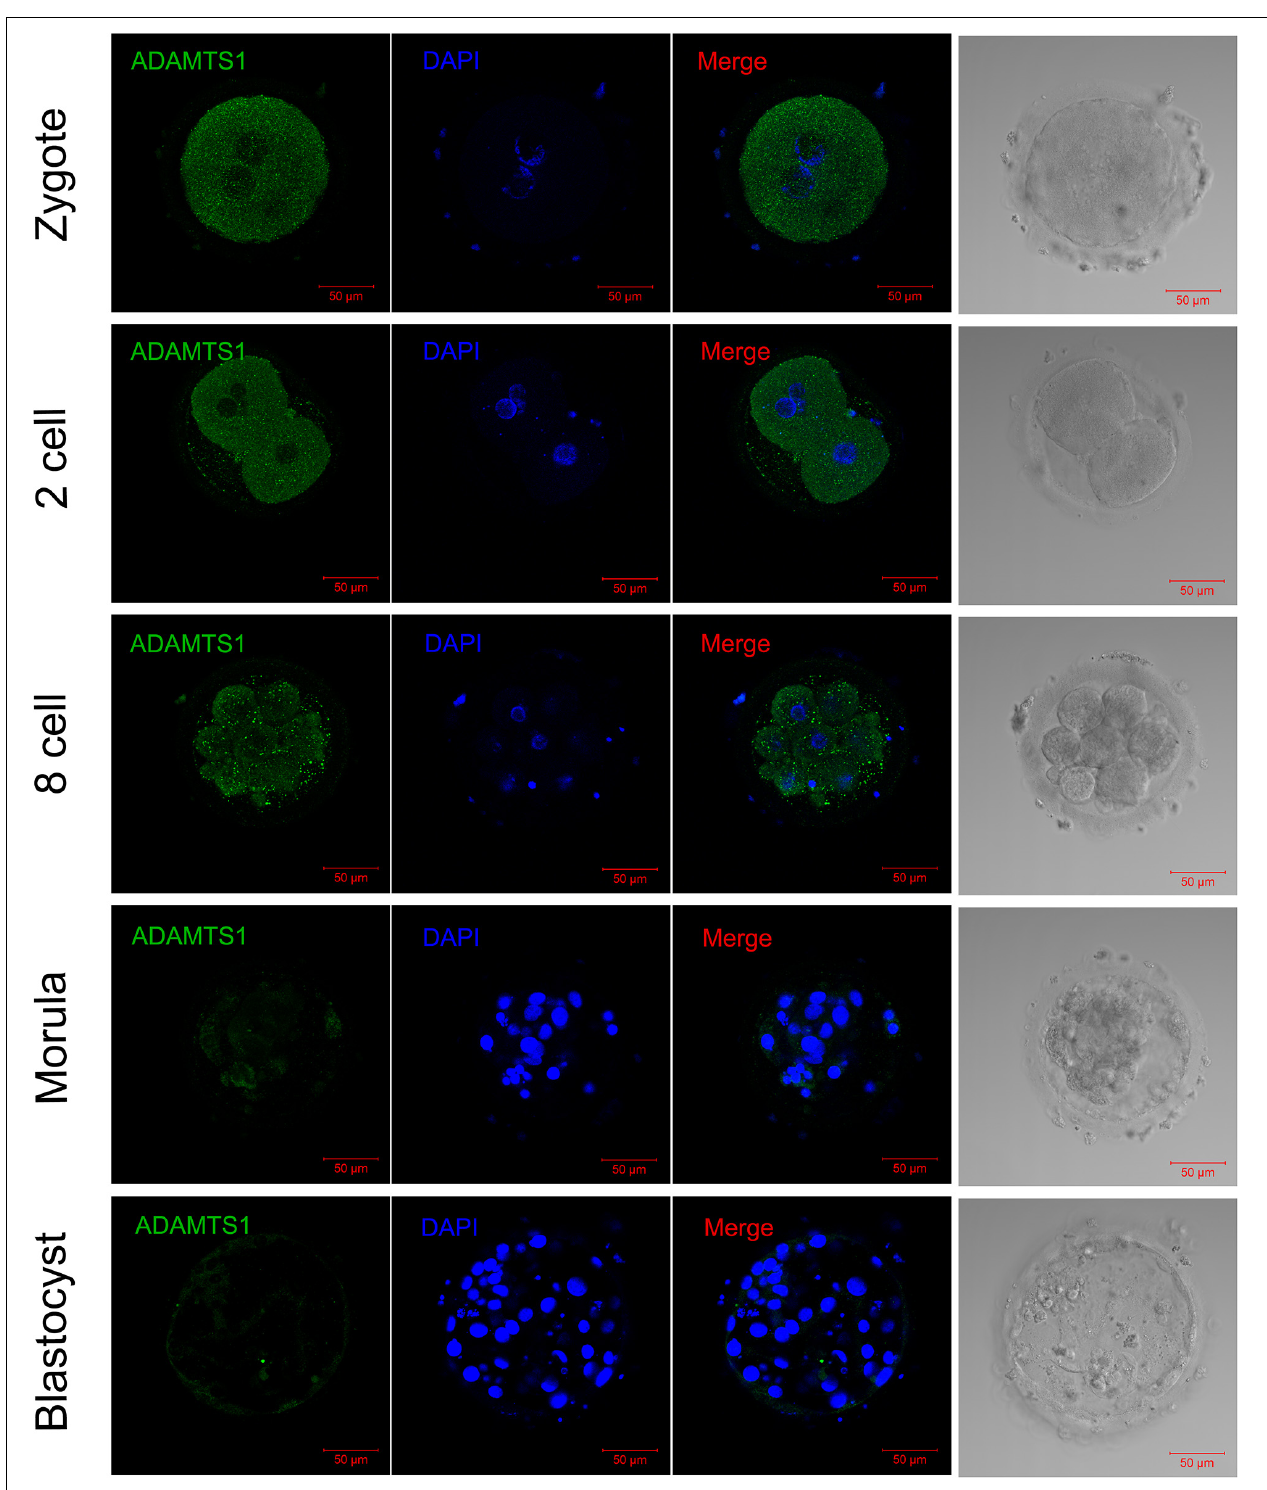
FIGURE 6 | The expression and localization of ADAMTS1 in various stages of embryos. Immunofluorescence of ADAMTS1 in human zygote, two cell embryos, eight cell embryos, morula and blastocyst, the control staining without ADAMTS1 antibody. Green, ADAMTS1. Blue, DAPI indicates the nuclear localization signal. Bar = 50 µ